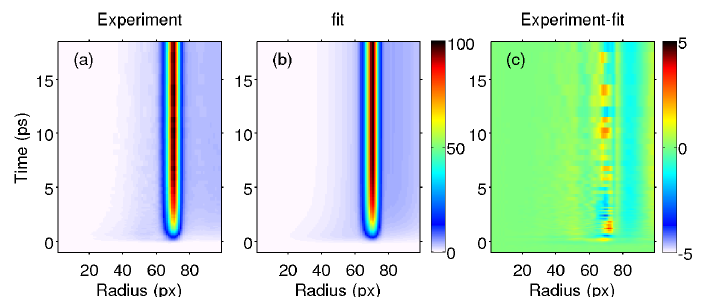
Figure 6. 2D representation corresponding to the angular integration of the I*( 2 P 1/2 ) fragment image sequence as a function of the delay time. ( a ) experimental measurement; ( b ) the corresponding fitting; and ( c ) the residuals corresponding to the experiment subtracted from the fit.